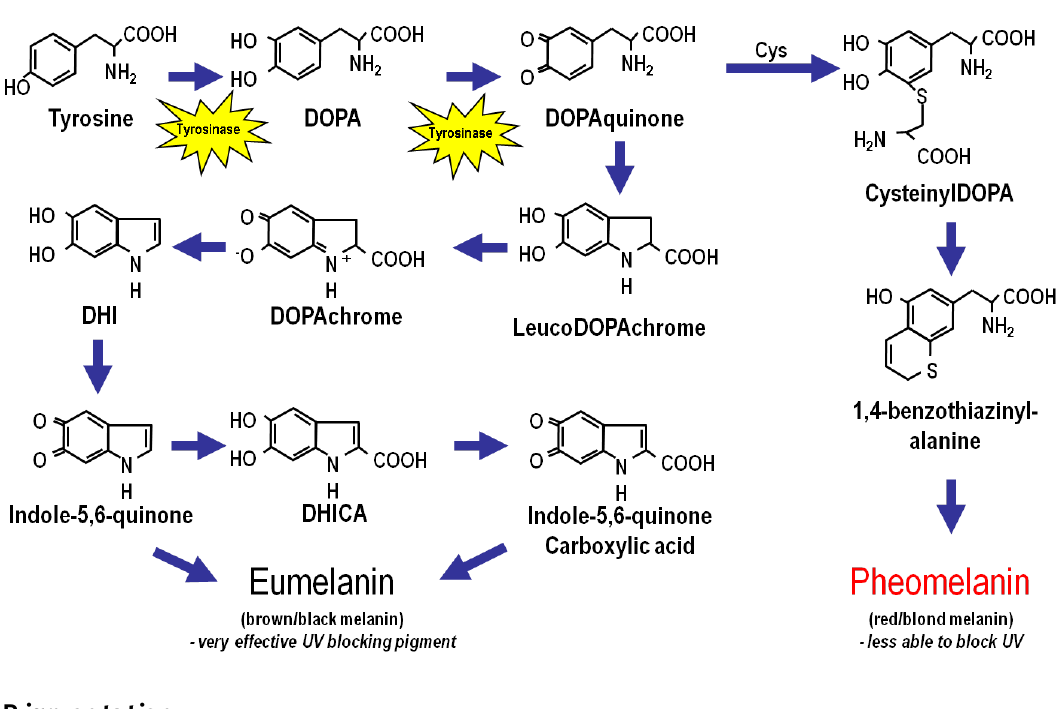
Figure 2. Melanin Biosynthesis. Melanin, a large bioaggregate composed of pigmented chemical species, is found in two major forms: the brown/black highly UV-protective ―eumelanin‖ pigment and the red/blonde UV-permeable ―pheomelanin‖. Both eumelanin and pheomelanin are derived from the amino acid tyrosine. Tyrosinase is the enzyme that catalyzes the rate-limiting synthetic reaction for both melanin species and when defective causes albinism. Incorporation of cysteine into pheomelanin results in the retention of sulfur into the pigment, which yields a light color to the final melanin product and may contribute to oxidative injury in the skin. The melanocyte stimulating hormone (MSH)–melanocortin 1 receptor (MC1R) signaling axis is a major determinant of the type and amount of melanin produced by melanocytes in the